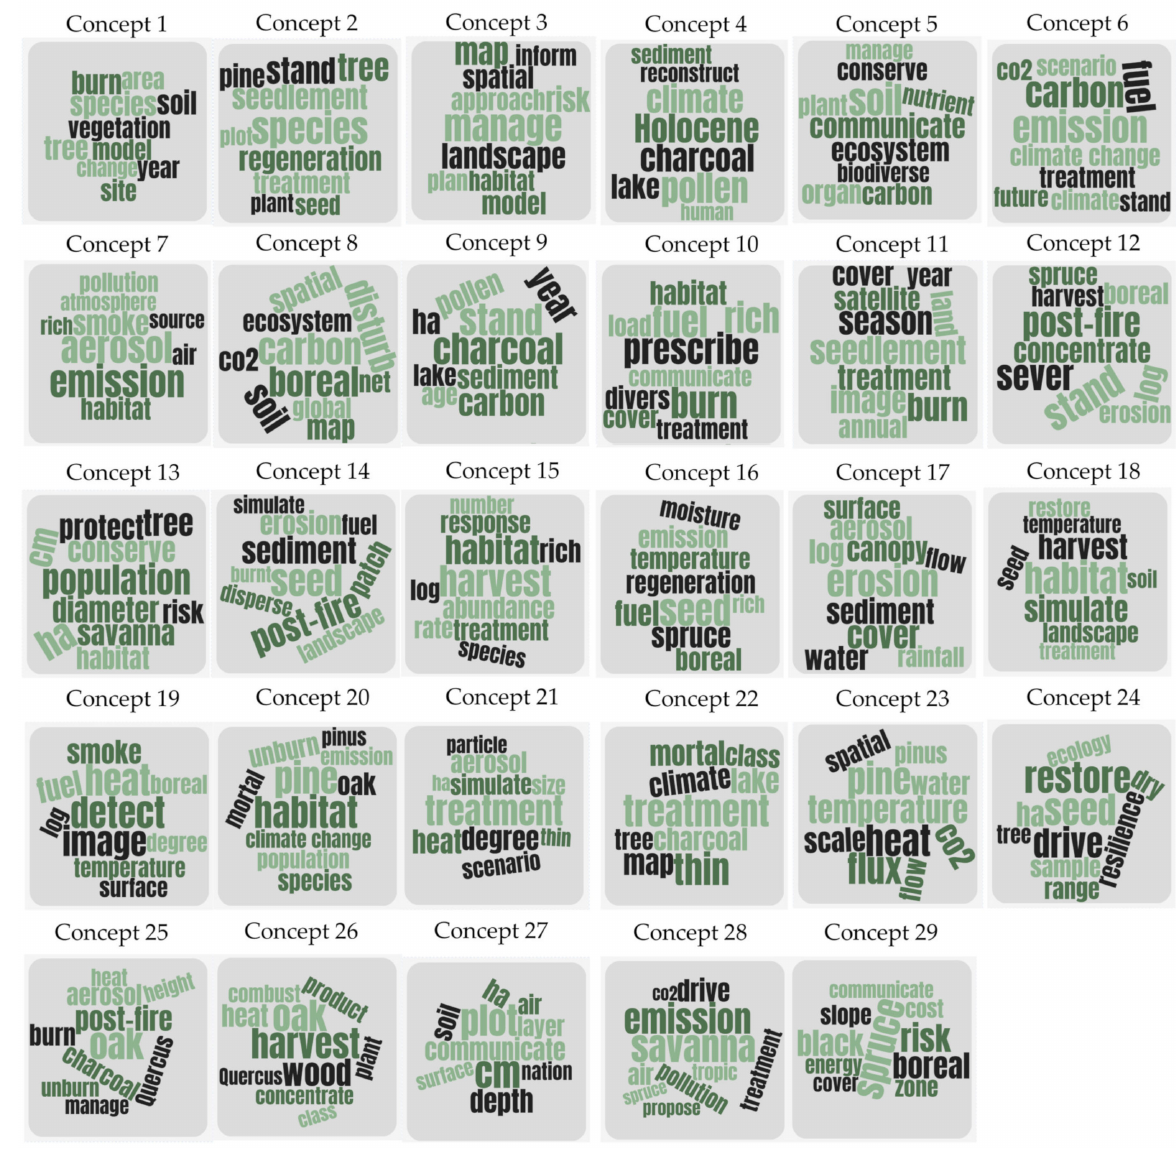
Figure 5. Word clouds of each concept for ten most important